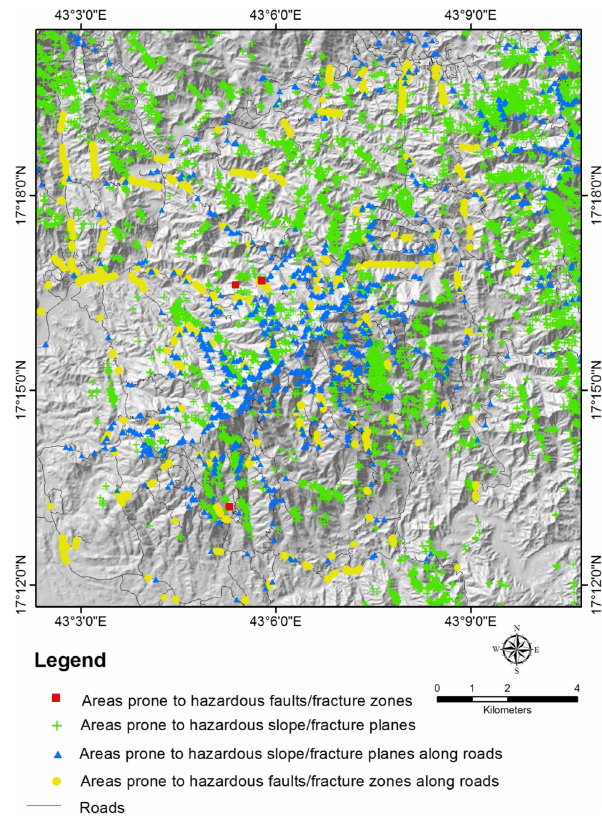
Figure 10. Susceptibility map showing the distribution of picture elements along (blue and yellow symbols), and away from (red and green symbols) roads that are susceptible to failure by motion on fracture planes. Information pertaining to the extrapolation tech- nique that was applied to assign fracture set information to pixels is also provided in the figure; green and blue symbols refer to extrapo- lation related to “first observation”, and the red and yellow symbols are related to “second observation” (refer to Sect.